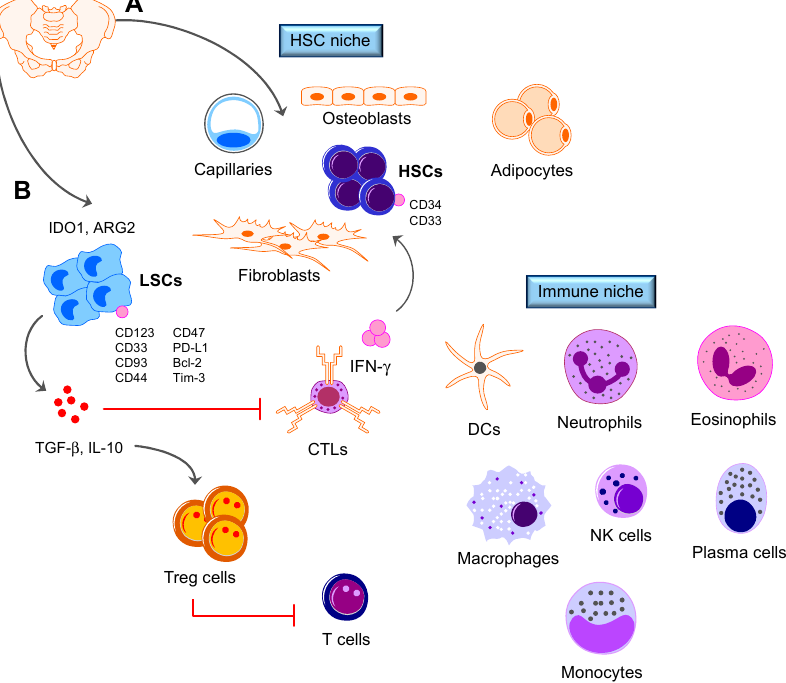
Figure 1. The immune landscape of normal ( A ) and leukemic ( B ) BM. The BM microenvironment hosts a variety of immune cell types, including T cells, B cells, plasma cells, dendritic cells, neutrophils, macrophages, eosinophils and regulatory T cells. Immune cells support steady-state and emergency hematopoiesis, provide an immune privileged niche that protects HSCs from immune destruction and contribute to leukemia control. Candidate leukemia stem cell markers, including CD123 [5], CD44 [6], Bcl-2 [7] and Tim-3 [8], as well as markers of normal hematopoietic stem cells are shown. Microenvironmental soluble factors, such as interferon (IFN)- γ produced by cytotoxic T cells, might promote leukemia cell proliferation [9]. IDO1 = Indoleamine 2,3-dioxygenase-1; ARG2 = arginase-2; LSC = leukemia stem cell; HSC = hematopoietic stem cell; DC = dendritic cell; CTL = cytotoxic T lymphocyte. Red lines denote feedback inhibition.